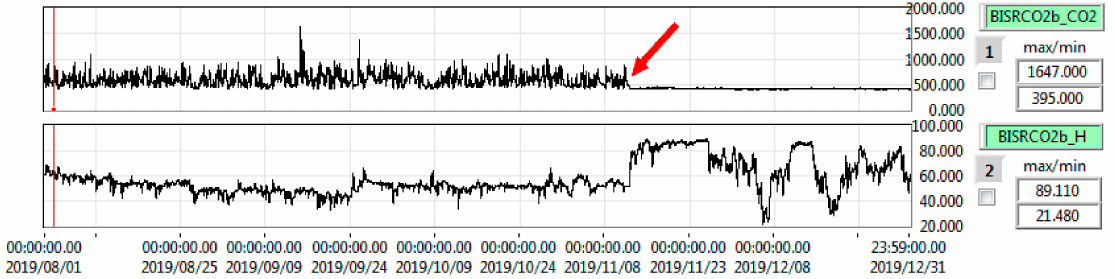
Figure 20. Dependence of measurements on the position of the CO2 sensor in Bisoca